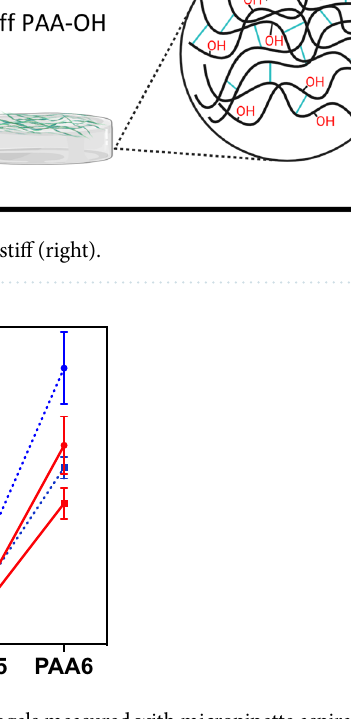
Figure 10. Elastic modulus of PAA and PAA-OH hydrogels measured with micropipette aspiration and macroindentation. Mean values and standard deviations are reported in Table